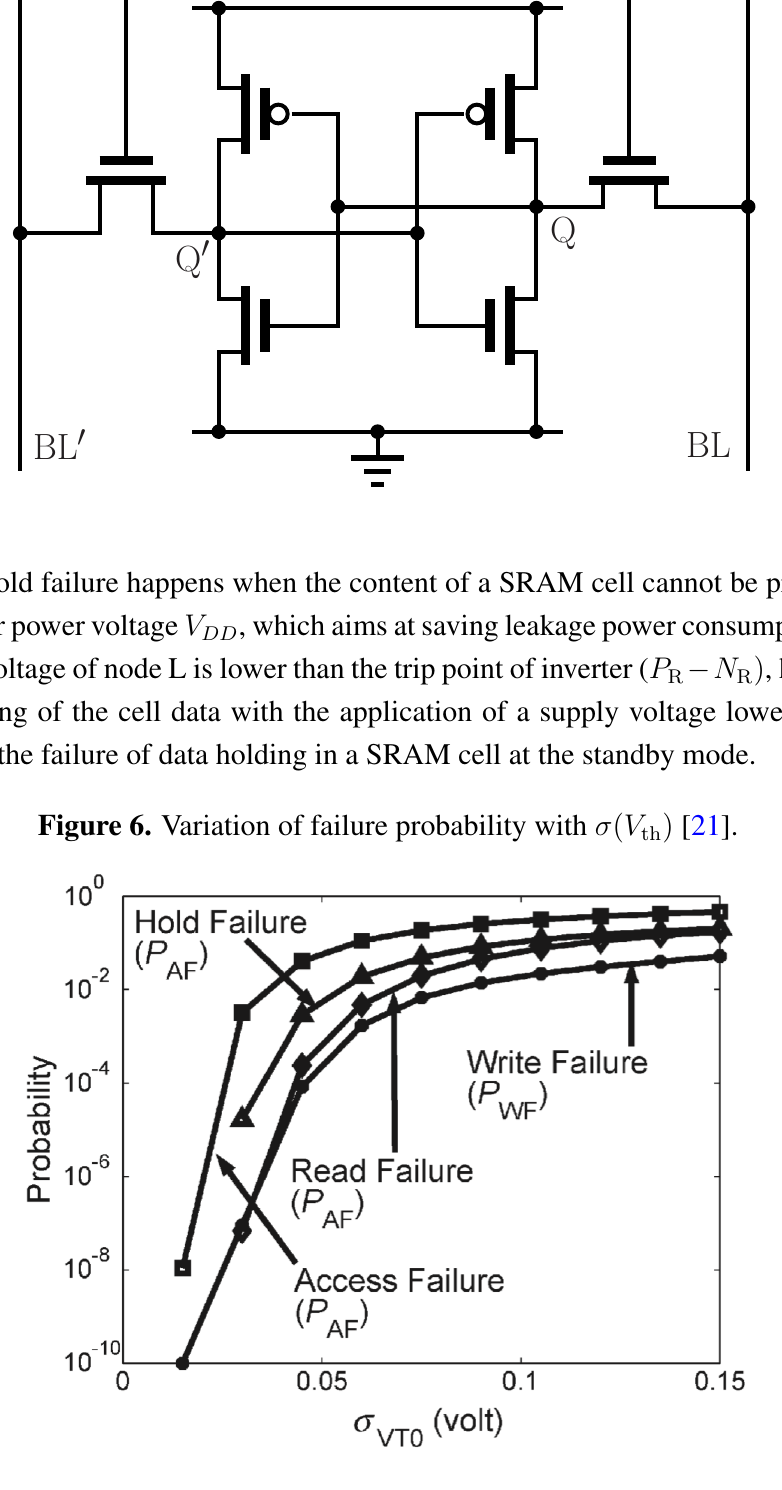
Figure 5. Transistor network of a standard SRAM cell.